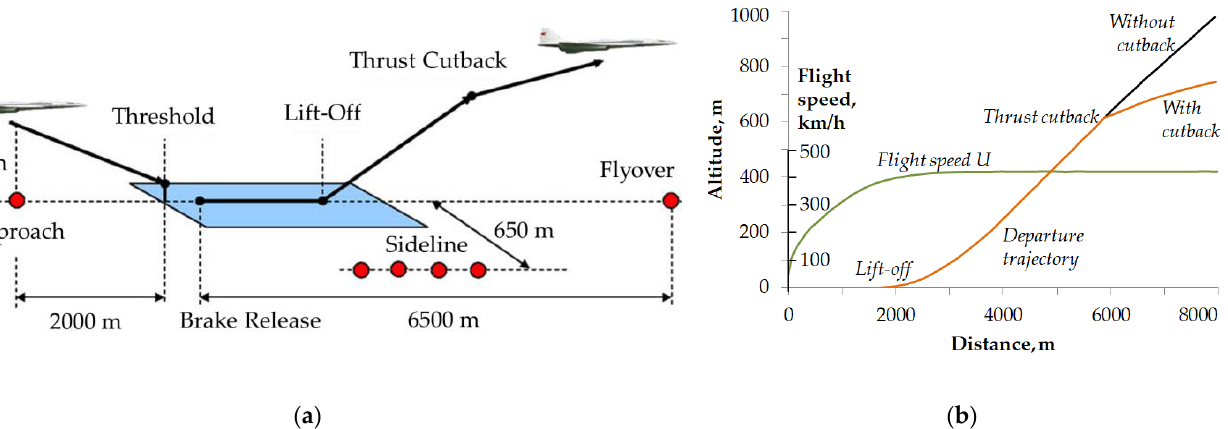
Figure 1. Parameters for Tupolev-144: ( a ) a scheme of the location of noise certification points; ( b ) the aircraft departure trajectory and flight